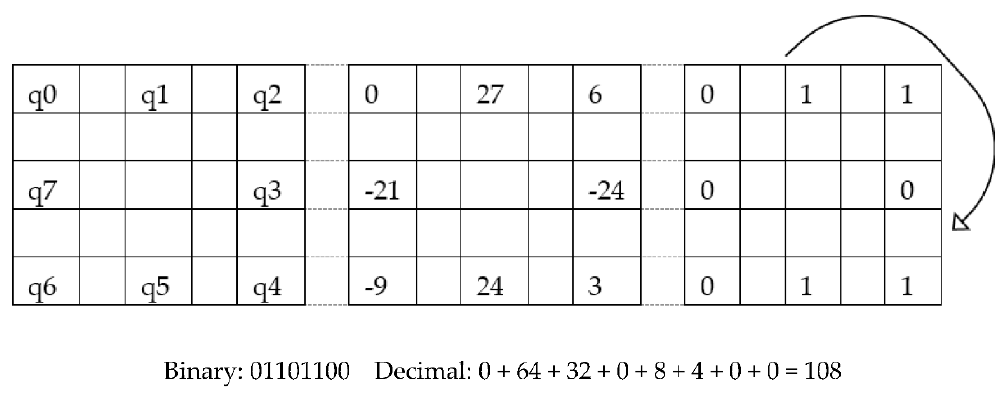
Figure 9. Calculation of LBP (8, 2) .